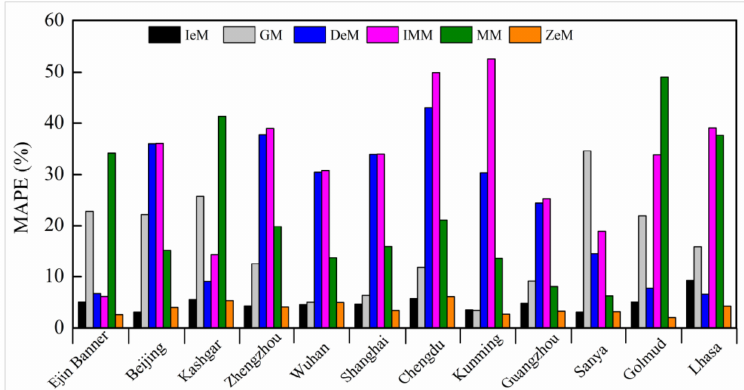
Figure 2. MAPE values for the six models at 12 selected